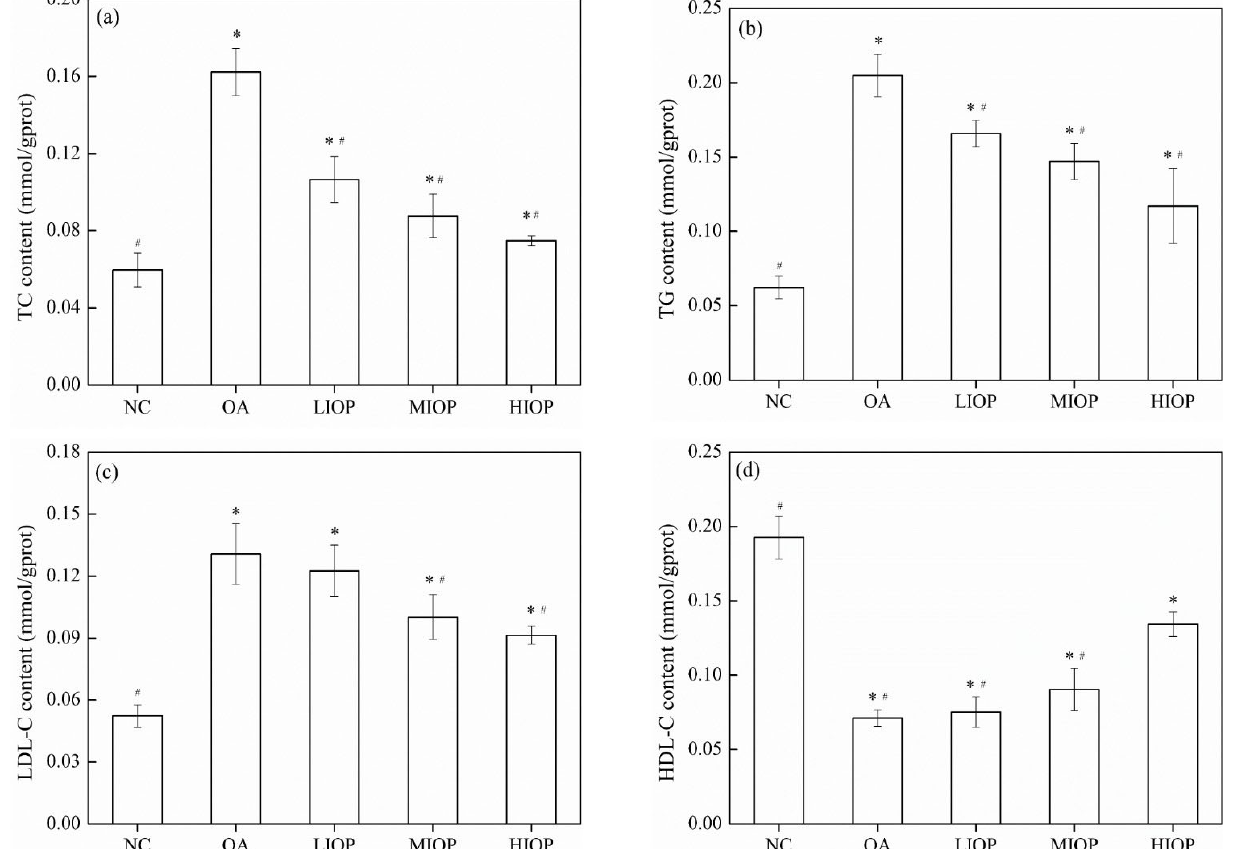
Figure 4. Effect of IOP on TG, TC, HDL-c, and LDL-c contents of OA-induced HepG2 cells. ( a ): TG; ( b ): TC; ( c ): HDL-C; ( d ): LDL-C. Each value represents the mean of six replicates, and error bars indicate standard deviation ( ± SD). * p < 0.05, versus the NC group; # p < 0.05, versus the OA group.